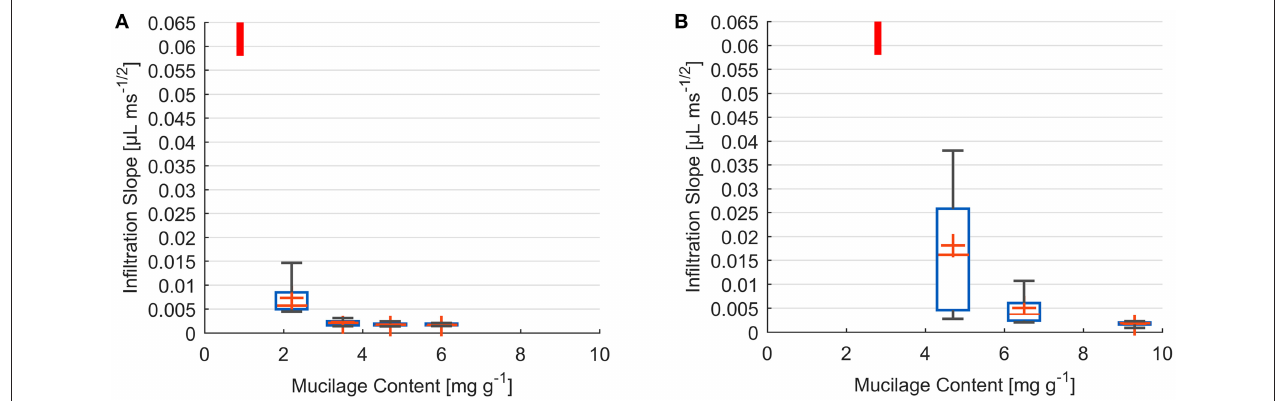
FIGURE 3 | Box and Whisker plots of infiltration slope derived from fit of volume against square root of time for water drops placed on glass bead (A) and sand (B) samples of different dry mucilage content; Lowest measured mucilage content (infiltration time below detection limit) indicated by red bar; Slope at 300ms detection limit ≥ 0.058 µ L ms − 1 / 2 ; Whiskers mark the upper and lower 25% (quartiles) of values excluding outliers exceeding 1.5 times the interquartile range (box); Median indicated by red line within the box separating second and third quartile. Mean indicated by red cross.